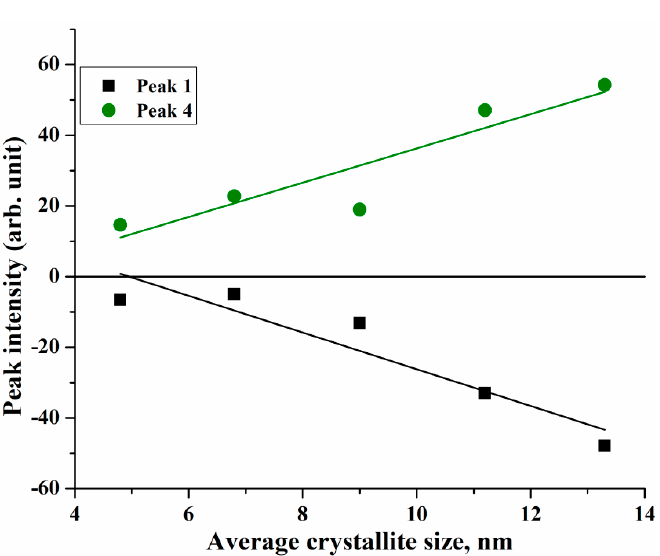
Figure 5. The change in the intensity of peaks 1 and 4 with increasing average crystallite size of Fe 3 O 4 nanoparticles.